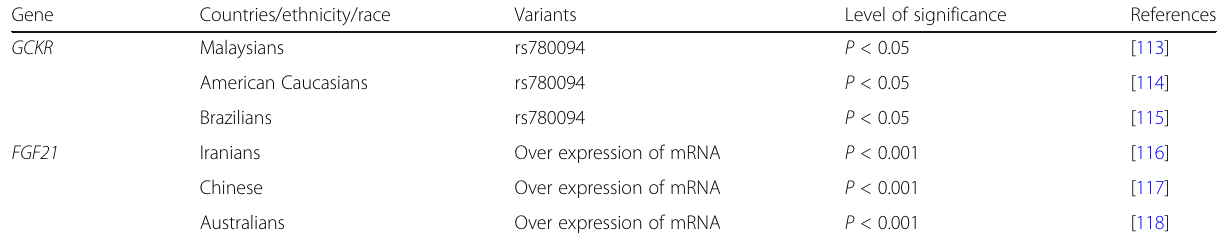
Table 2 Most prevalent gestational diabetes mellitus genes across countries, ethnicity, and race in the world (Continued) Gene